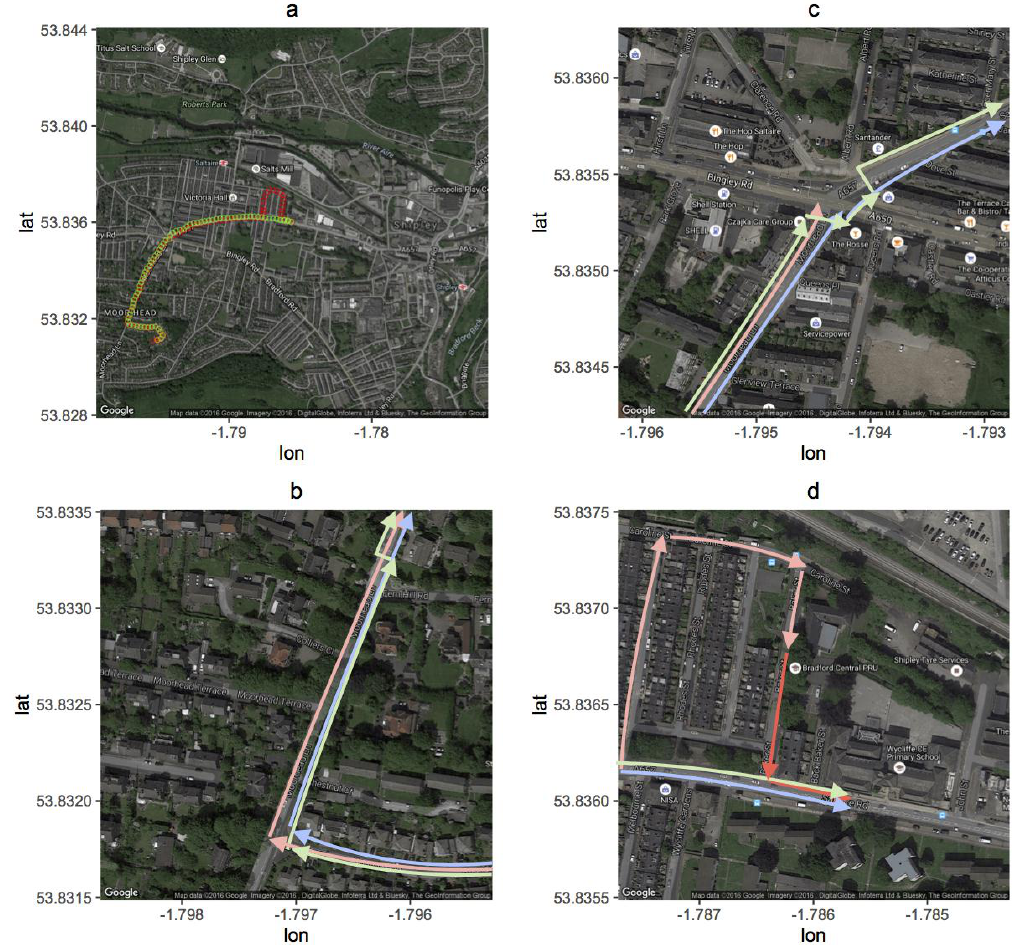
Figure 1. Map depicting the route to school in the morning. ( a ) The journey to school begins in the bottom left-hand corner (the house) and finishes in the top right-hand corner (the school). The green markers represent the route for the walkers while the red markers are those for the car commuter. The detour at the end of the journey for the car commuter is for parking the car; ( b ) The beginning of the route (red is the car, green is the North Walker and blue is the South Walker; ( c ) The intersection. ( d ) The final segment of the journey close to the school.